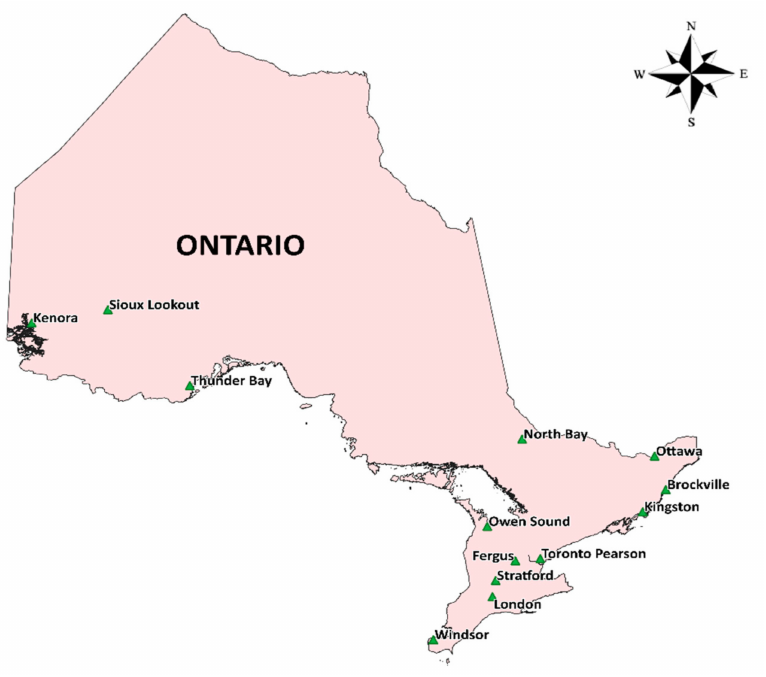
Figure 1. Spatial Distribution of the stations for the study area across Southern